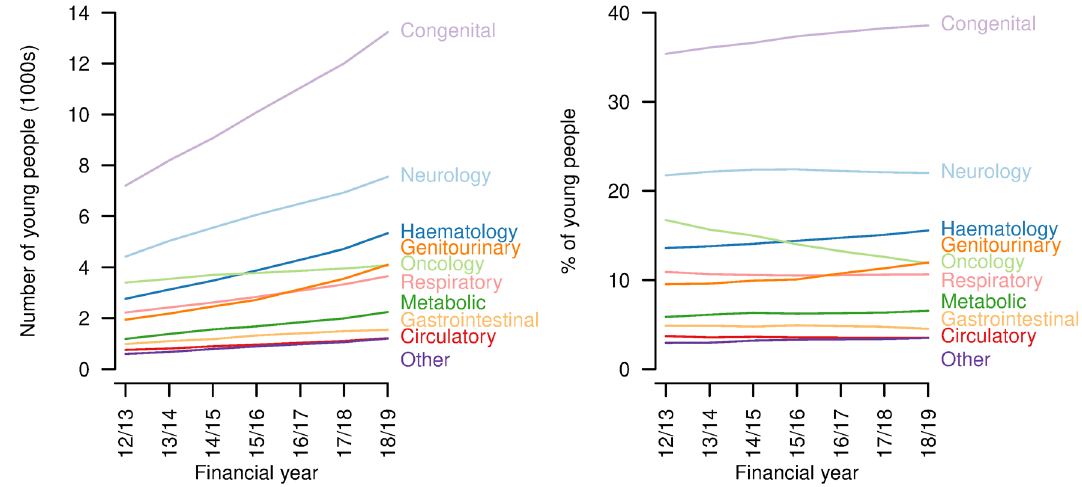
Figure 4. Categories of conditions of young people aged 14–19 years with life limiting conditions. Numbers (left) and proportions (right) of young people aged 14–19 years with a life-limiting condition with each category of condition, by